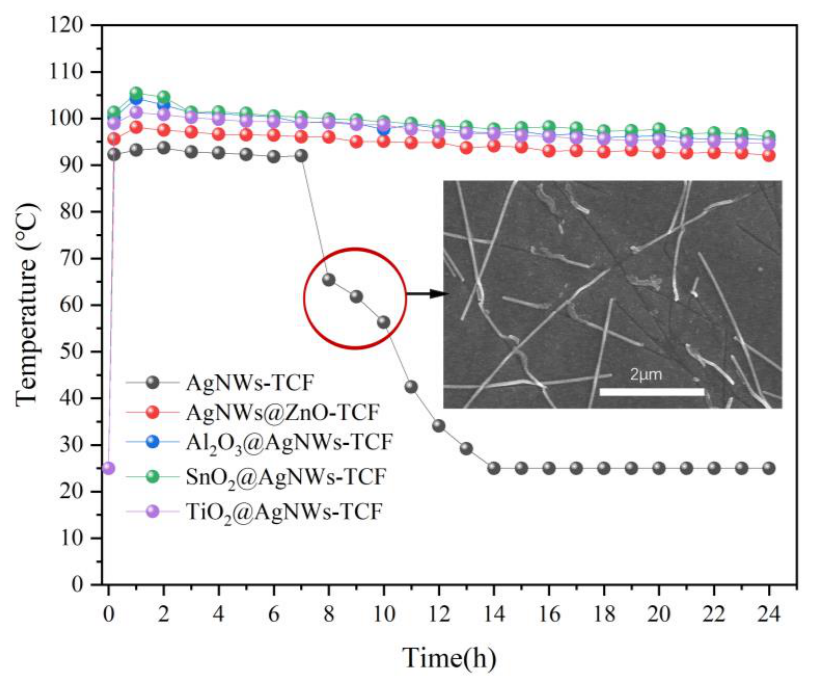
Figure 7. Thermal stability of AgNWs-TCFs before and after modification with MONPs. The inset is the SEM image of AgNWs-TCFs after its electrothermal failure.